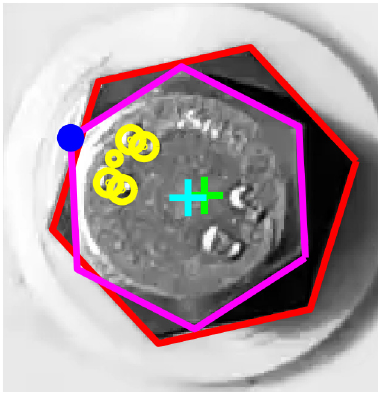
Figure 6. Geometrical edge features highlighted on the first frame of the video (Figure 3a): Outer hexagon model in red and its center in green, inner hexagon model in magenta and its center in cyan, 8.8 logo model in yellow, and the finally tracked vertex in blue.